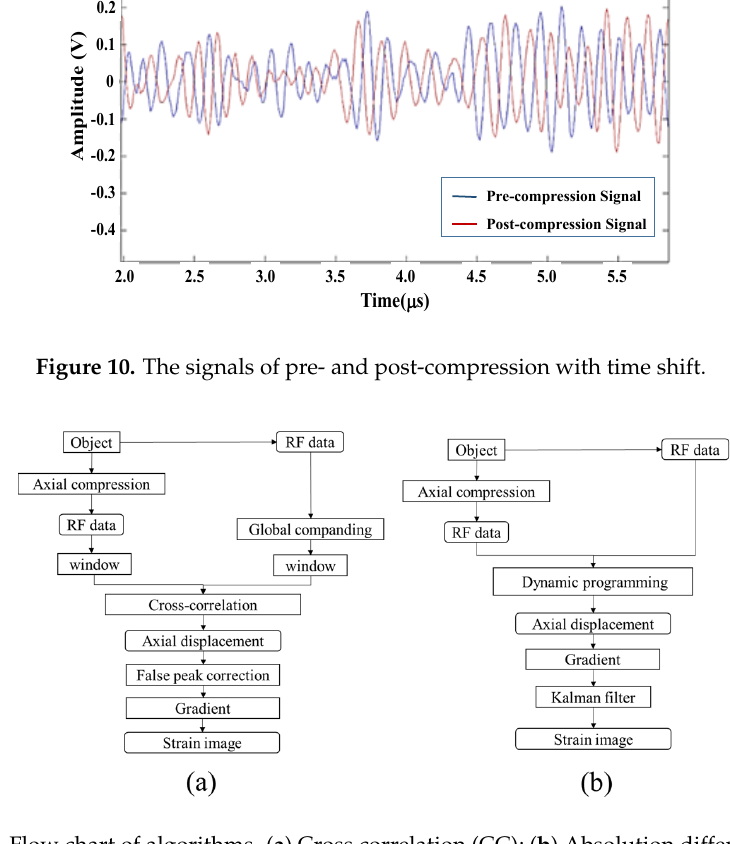
Figure 11. Flow chart of algorithms. ( a ) Cross correlation (CC); ( b ) Absolution difference (AD).